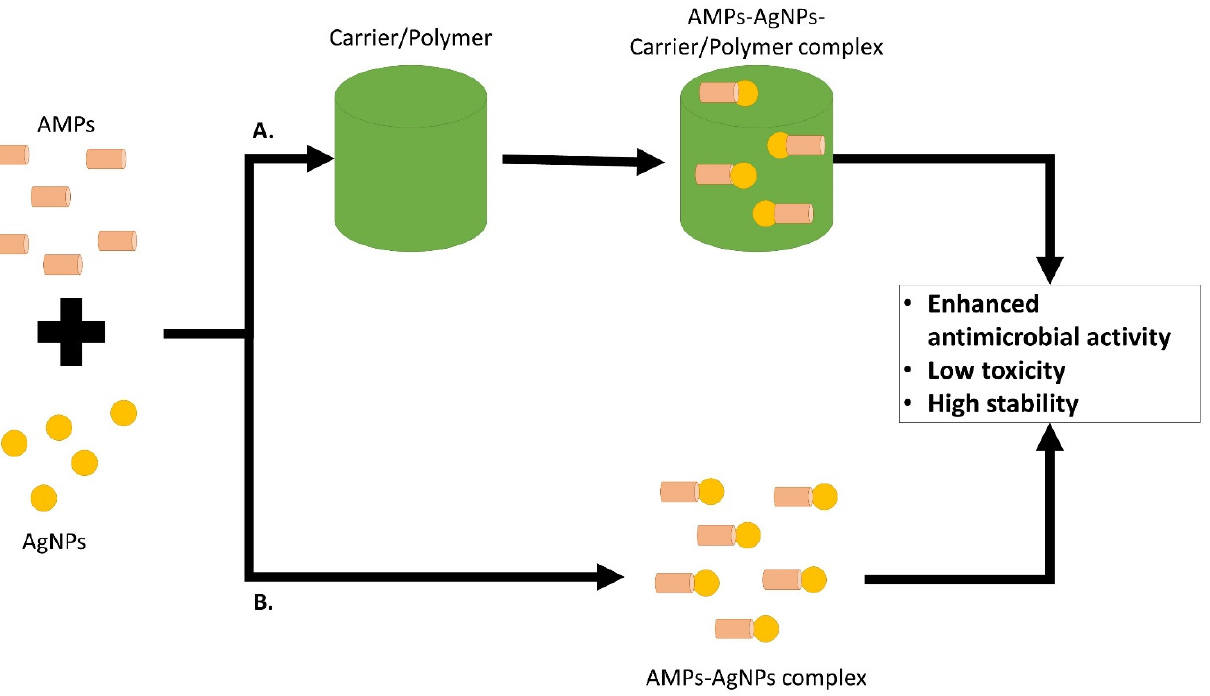
Figure 5. Combination of AMPs and AgNPs or together with the addition of carrier/polymer for a more effective delivery system to the target site, enhanced antimicrobial activity and lower toxicity effect in comparison to the agents on their own.